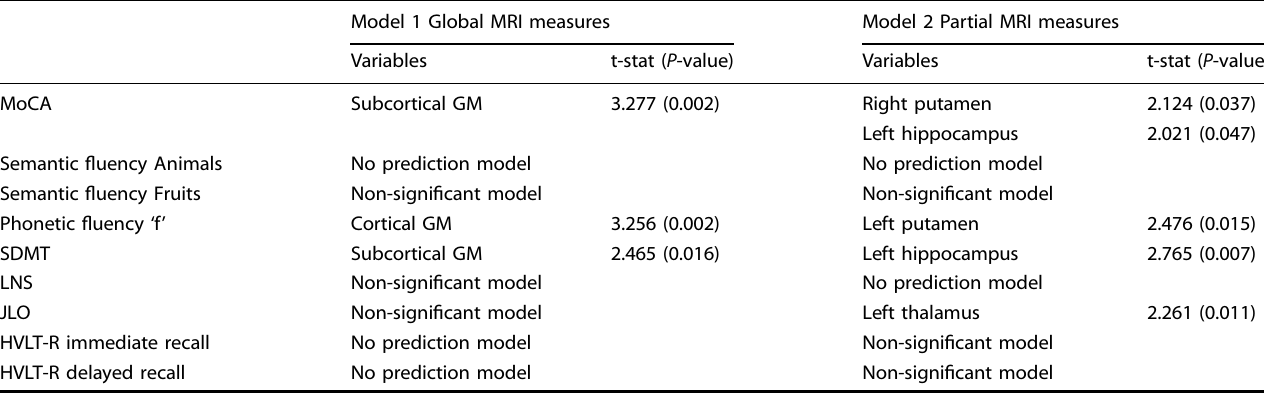
Table 3. Multiple regression results of global and partial volume ratios as predictors of performance in neuropsychological tasks in the PD-pRBD